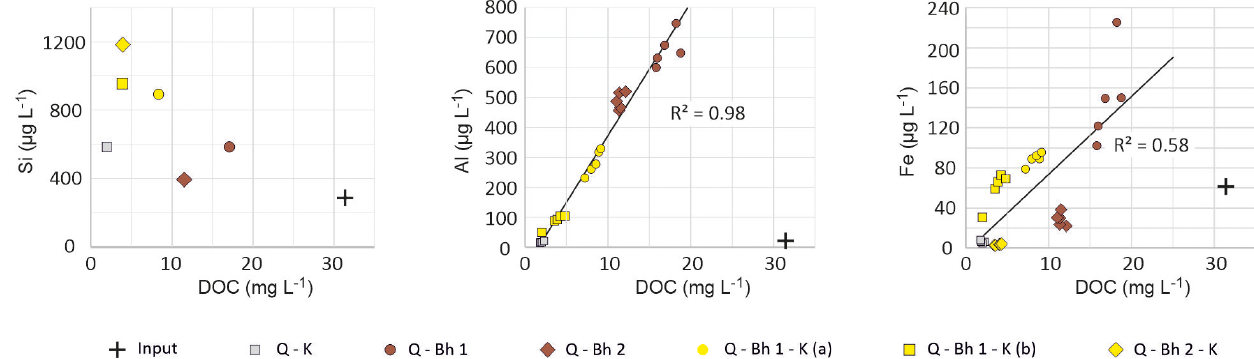
Figure 4. Relationships between DOC and dissolved Al, Fe and Si in column percolates. The cross represents the concentration in the input solution. Values are from composite samples for Si and from individual fractions for Al and Fe.